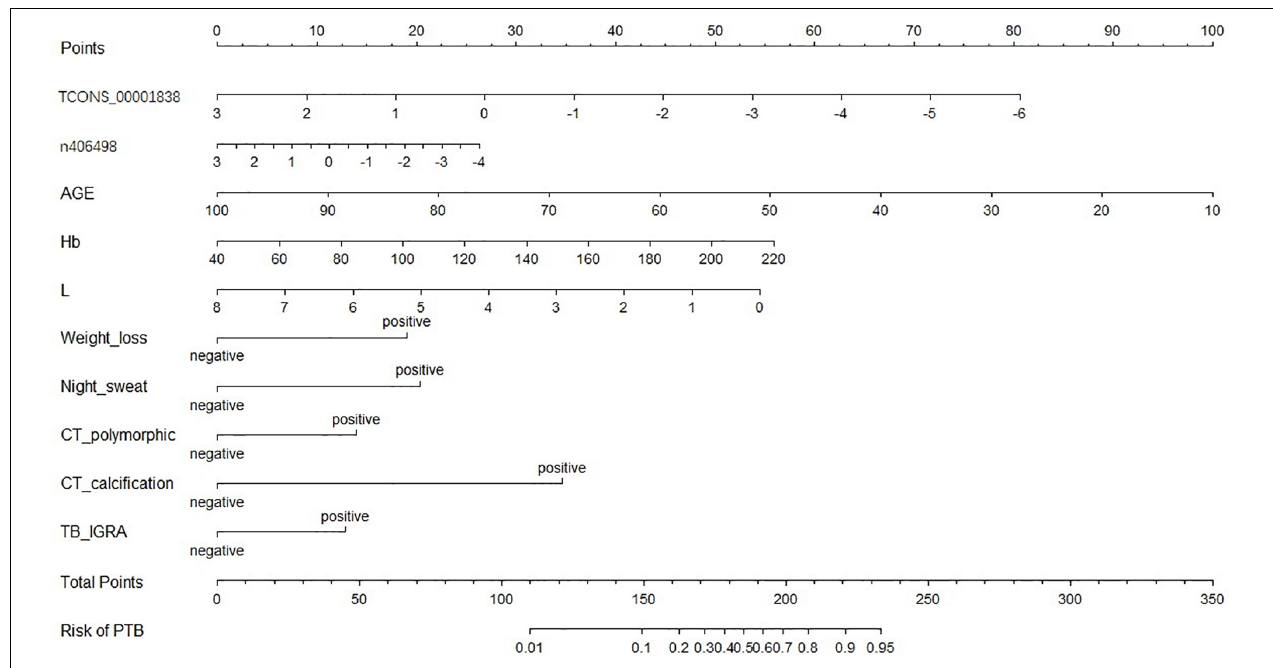
FIGURE 5 | Nomogram of the optimal model (“lncRNA + EHR”